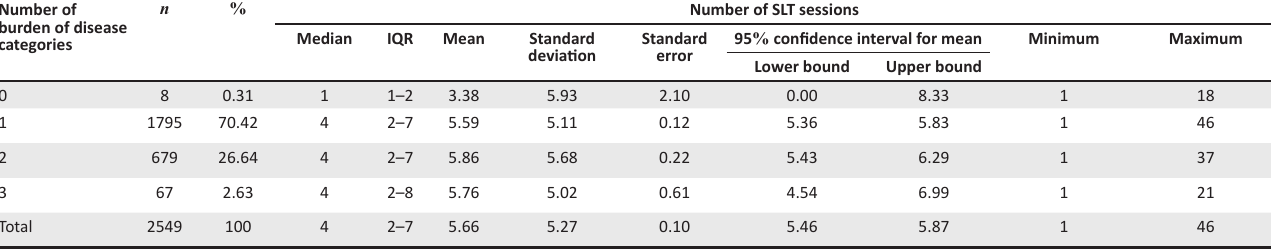
TABLE 4: Co-occurring burden of disease categories and number of speech-language therapy sessions. Number of burden of disease categories